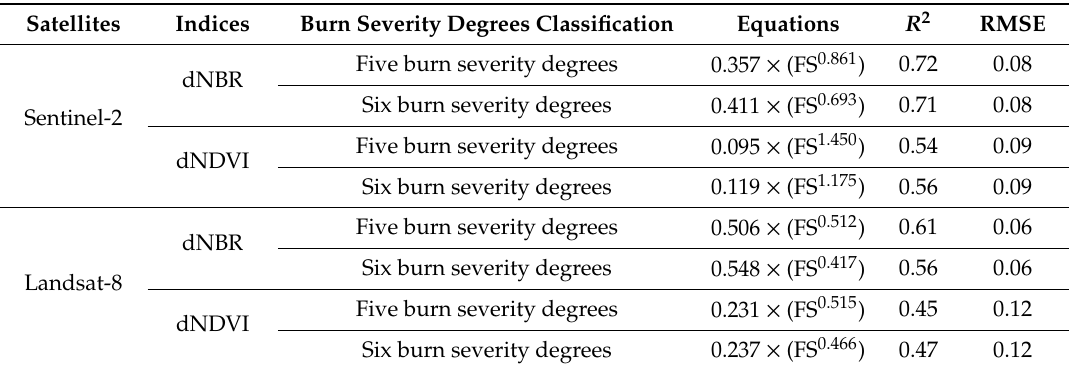
Table 3. Regression models results (equations, R 2 and Root Mean Square Error (RMSE)) between spectral indices (Differenced Normalized Burn Ratio and Differenced Normalized Difference Vegetation Index) and field severity (FS) measures in the Pontevedra fire.